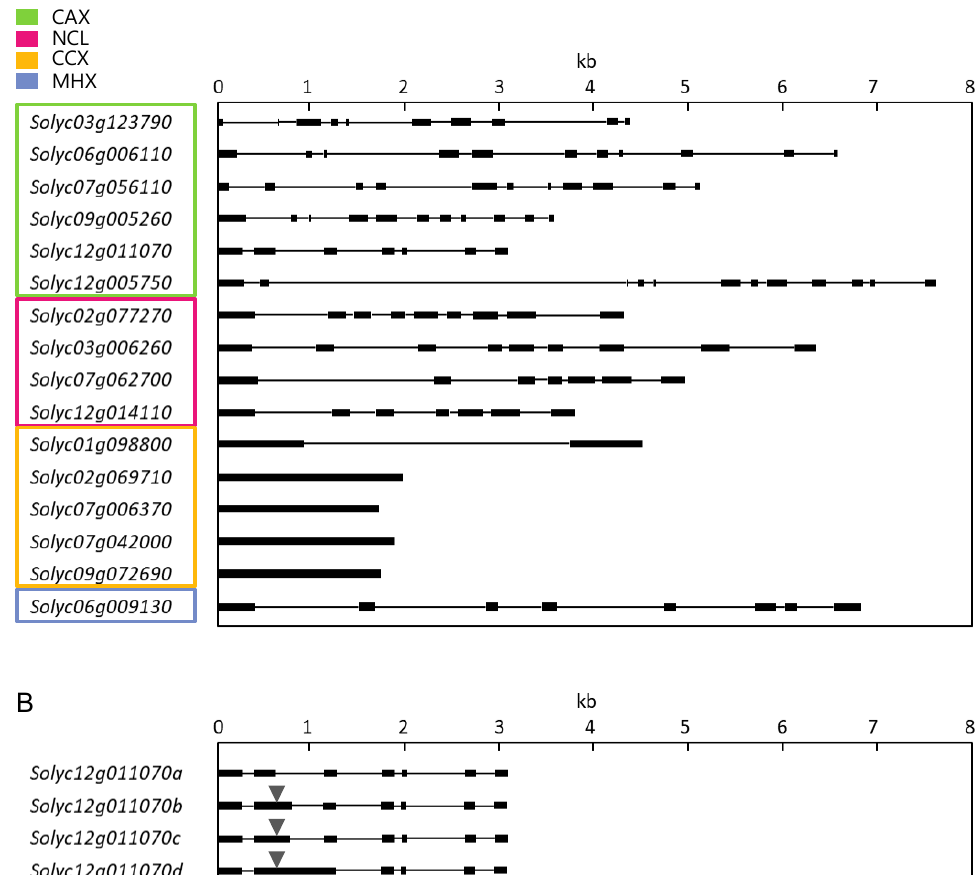
Figure 3. Intron and exon structure of SlCaCA superfamily genes. Exons and introns are shown as black boxes and black lines, respectively. The structure of 16 SlCaCA genes includes that of functional variant a of Solyc12g011070 ( A ). The structures corresponding to four mRNA variants of Solyc12g011070 are also shown as variants a–d, with arrowheads indicating premature stop codons ( B